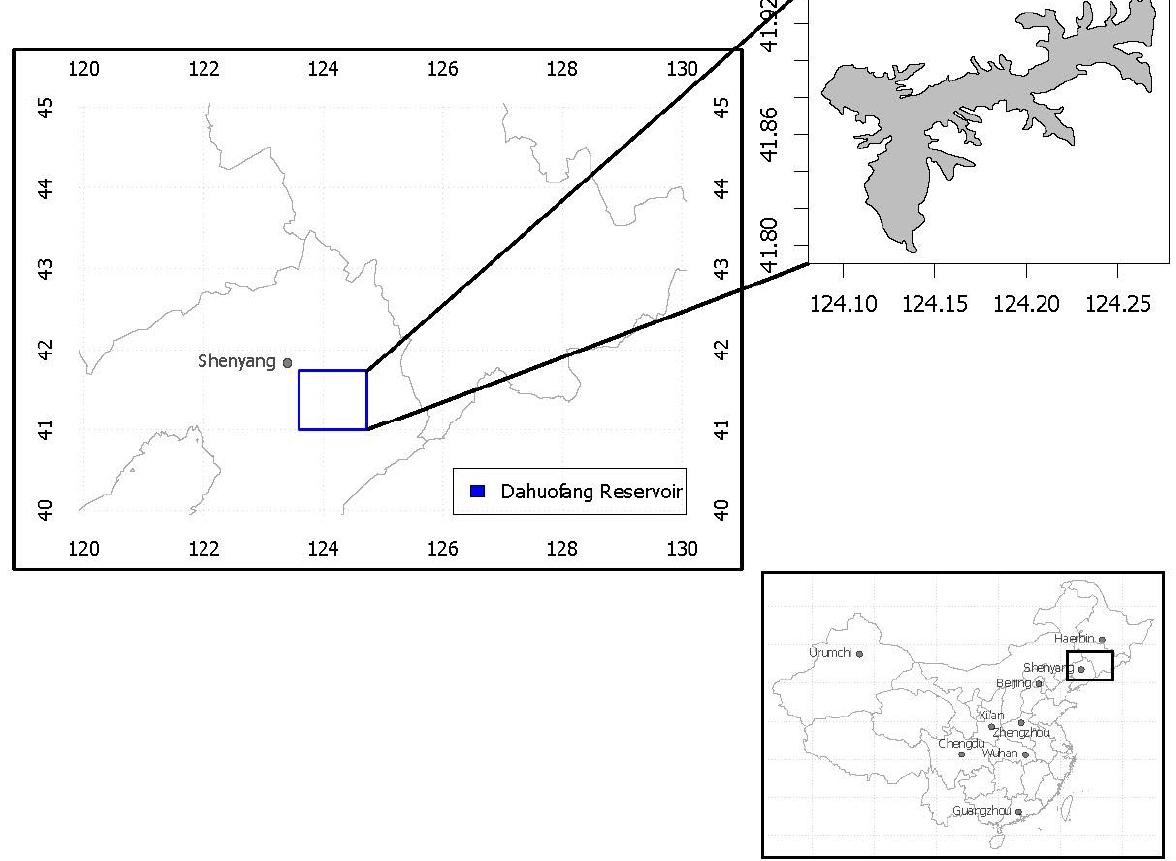
Figure 1. Location of DHF